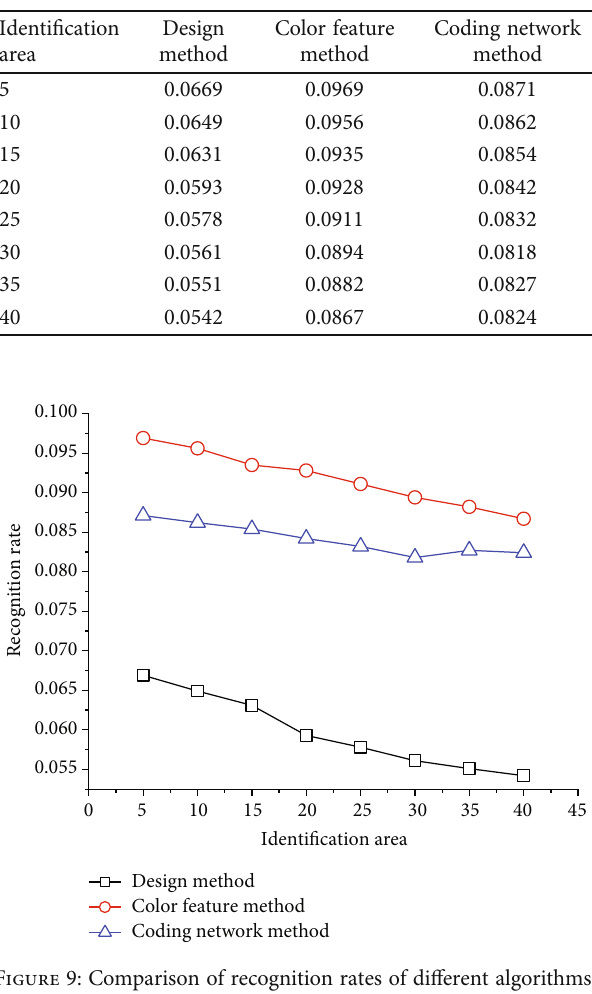
Table 2: Identi fi cation range and experimental results.